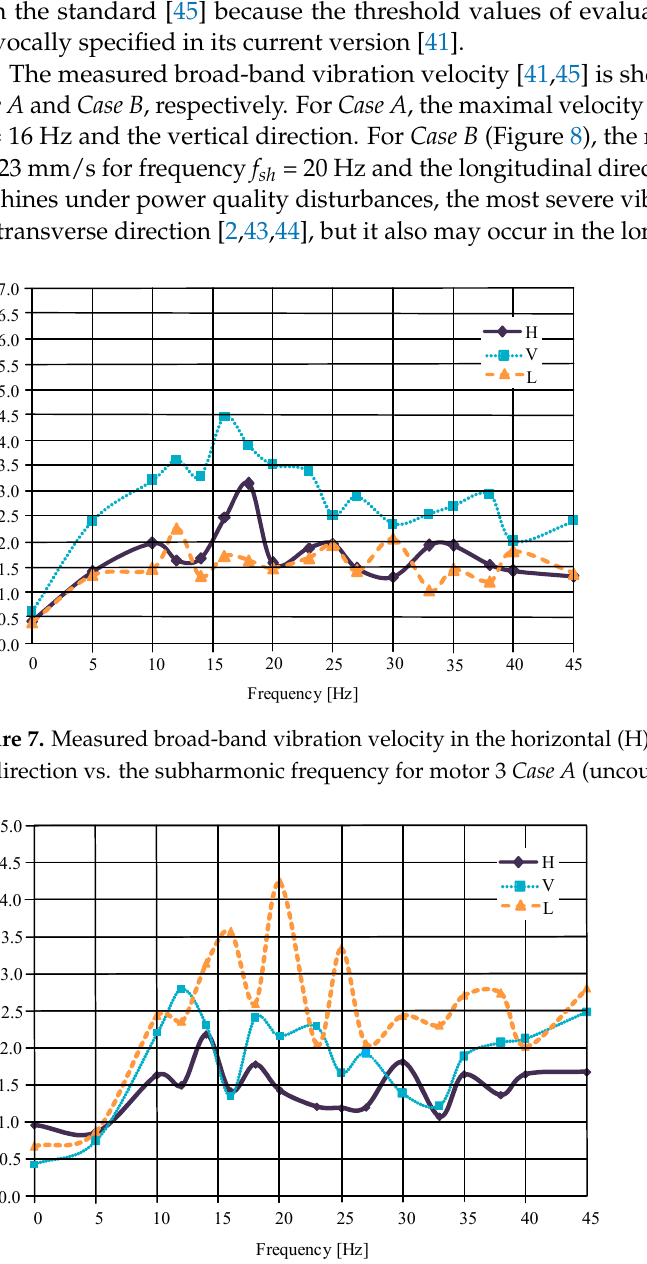
Figure 8. Measured broad-band vibration velocity in the horizontal (H), vertical (V) and longitudinal (L) direction vs. the subharmonic frequency for motor 3 Case B (a motor coupled with a DC generator).